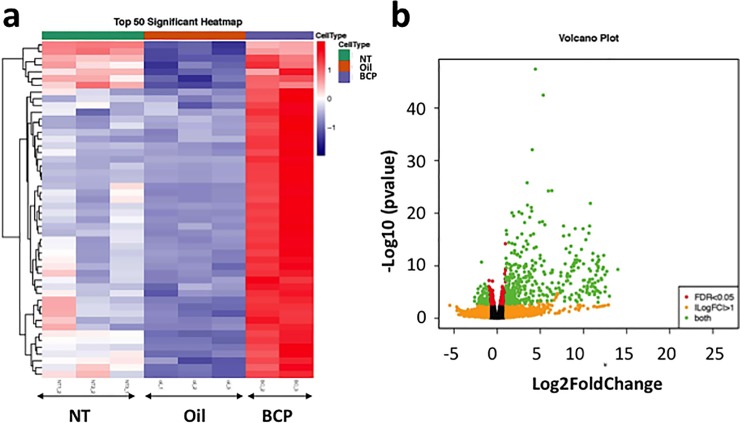
Results of RNA sequencing of post-surgery 17 hours skin and intact skin.Heatmap showing the top 50 significant gene expressions in the skin exposed to BCP (n = 2) or oil (n = 3), 17 to 18 hours post-surgery (inflammation stage), and in the skin of mice without skin excision (NT group) (n = 3). Comparison between BCP vs. oil (a) showed a clear difference between BCP and Oil. (b) Volcano plot from the comparison between BCP vs. Oil. Y-axis shows log10 (p value) and X-axis shows log2 fold change value.